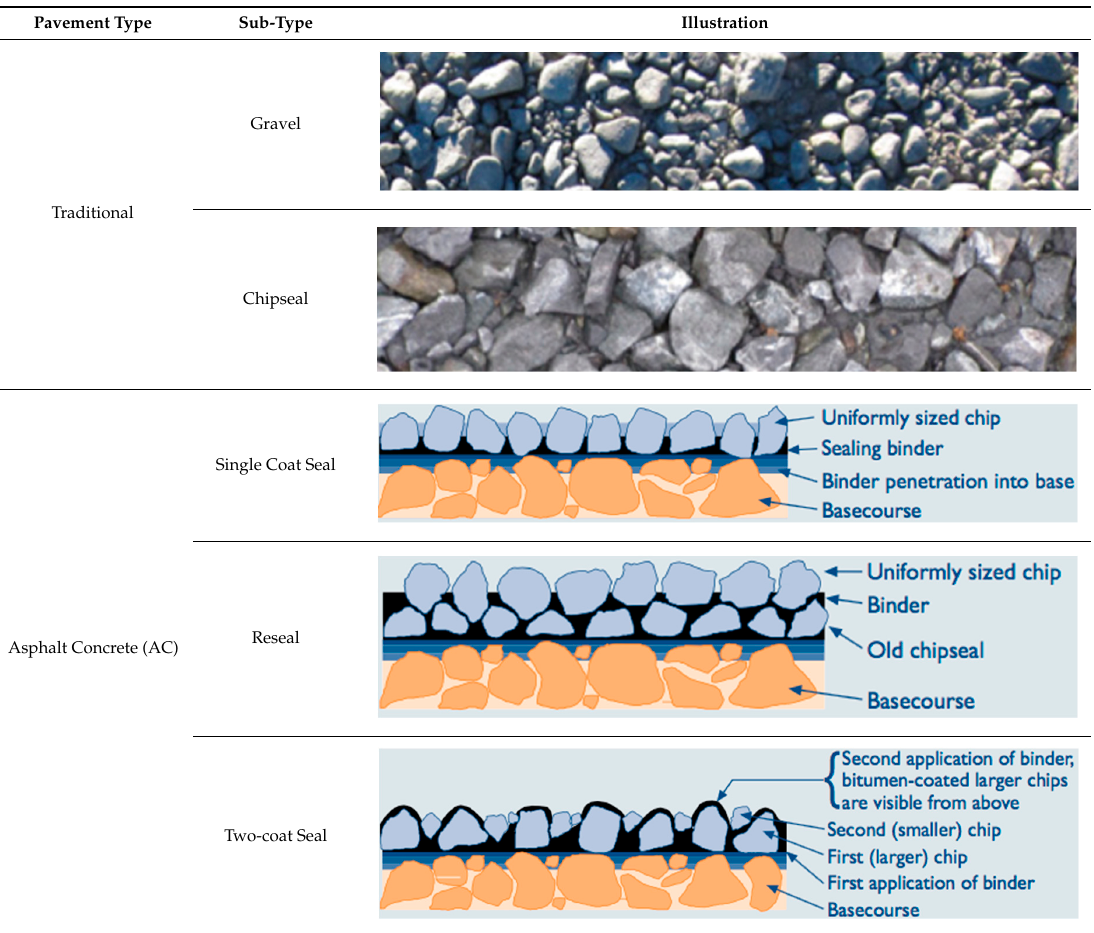
Table 11. Illustrations of different types of pavements (modified from NZ Transport Agency, 2014 [182], Figures 1.6–1.19; reprinted with permission from Ms. Helen Lane on behalf of NZ Transport Agency).